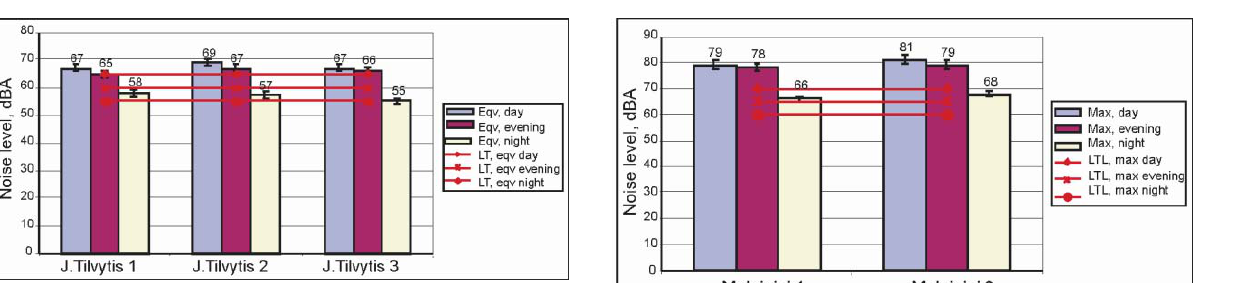
Fig. 8. Dynamics of equivalent noise levels in J. Tilvytis street within twenty four hours